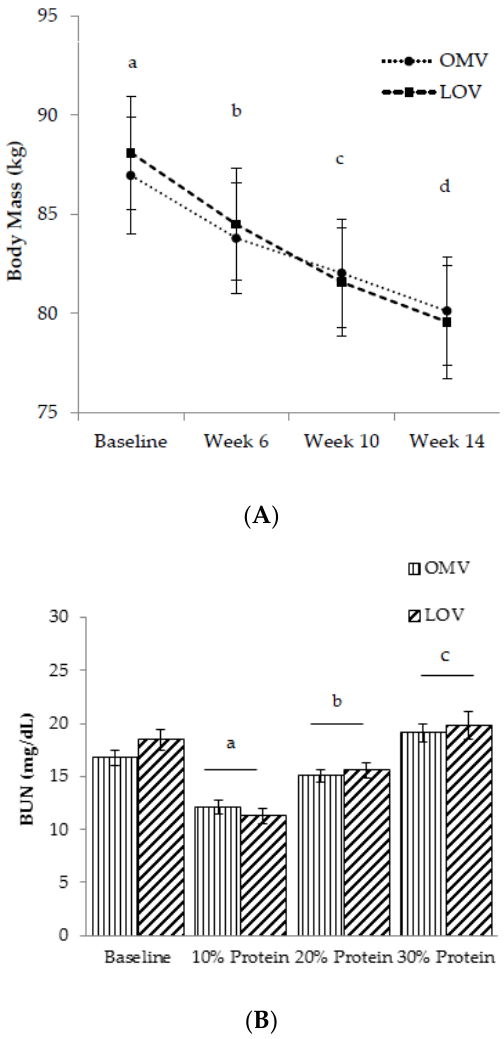
Figure 3. ( A ) Body mass status overtime; and ( B ) fasting blood urea nitrogen (BUN) at the end of each 4-week period. a,b,c,d : Values with different letters differ significantly, p < 0.001.